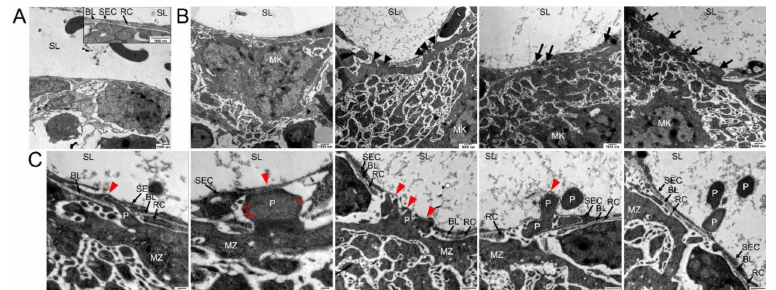
Figure 3. Transmission electron microscopical analysis of megakaryocyte (MK) transmural passage. ( A ) TEM image of components of the blood-BM-barrier, consisting of sinusoidal endothelial cells (SE) which are partially underlined by a basal lamina (BL) and covered by reticular cells (RC) to a large extent. No detection of any preformed pores in the sinusoidal endothelial cells was observed. Sinusoidal lumen (SL). ( B ) TEM images of approaching MKs. Before platelet protrusion, MKs approach the continuous endothelium with their MZ at various points (arrowheads) followed by invagination of MK protrusions into the continuous sinus endothelium (arrows). ( C ) TEM images of different steps of platelet (P) protrusion at higher magnification. At MK/SE contact sites (red arrowhead), MK protrusions provoke local retraction of reticular cells and disintegration of the basal lamina, followed by invagination of MK protrusions into the continuous sinus endothelium, massive stretching of SEs and subsequently rupture of the sinus endothelium and transcellular pore formation. Fine filaments are visible that anchor the protrusion to the SEC (red arrows).